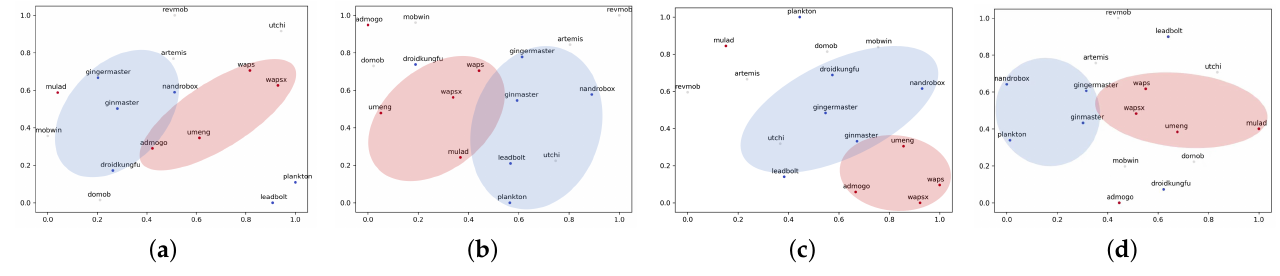
Figure 3. The relationship between the malware detection performance and the malware charac- teristics. Red color represents the characteristics of displaying ads and blue color represents the characteristics of stealing user data. ( a ) csbd. ( b ) drebin. ( c ) mamadroid. ( d )